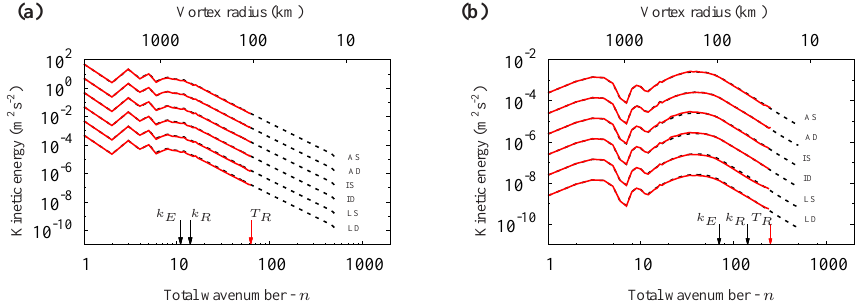
Figure 5. Scale by scale comparison of the benchmark simulation (dashed line) to the LES variants (red solid line). Kinetic energy spectra at the upper level of the (a) atmosphere and (b) ocean. The top pair of spectra exhibit the true energy, with subsequent pairs shifted down for clarity. Spectra are labelled with the associated subgrid parameterisation of anisotropic stochastic (AS), anisotropic deterministic (AD), isotropic stochastic (IS), isotropic deterministic (ID), scaling law stochastic (LS), or scaling law deterministic (LD). The truncation ( T R ), Rossby ( k R ) and energy-containing ( k E ) wavenumbers are labelled on the horizontal axis.